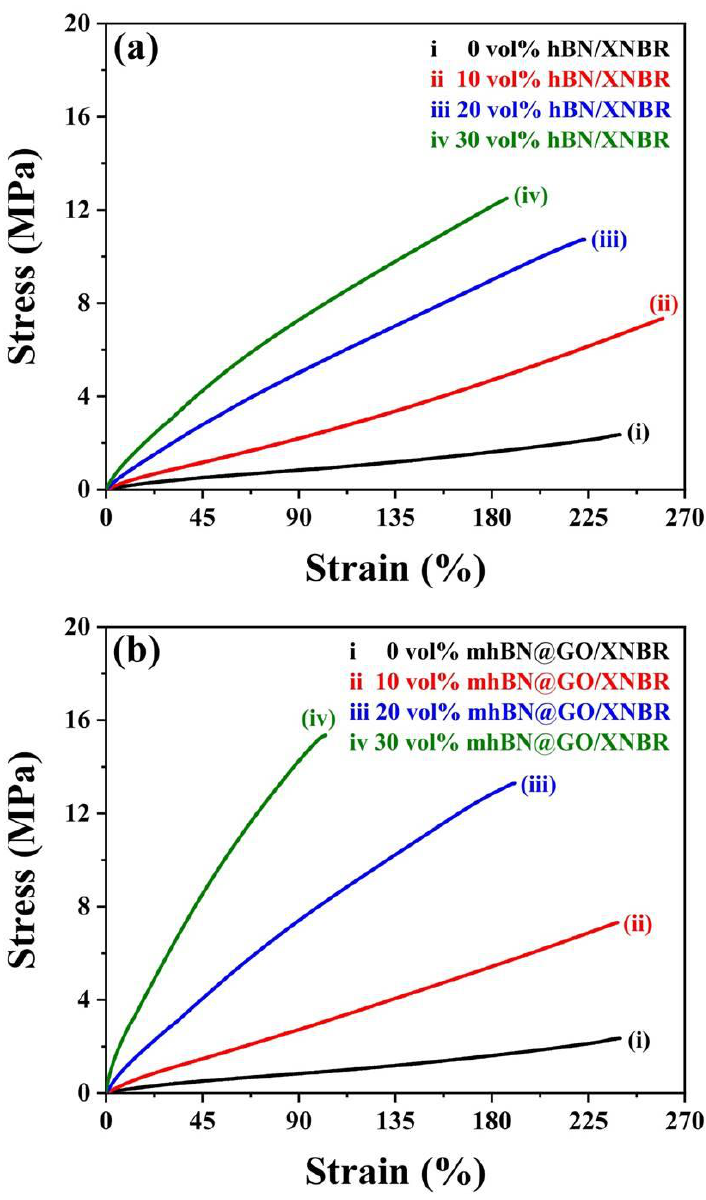
Figure 6. Mechanical properties of ( a ) hBN/XNBR and ( b ) mhBN@GO/XNBR composites.